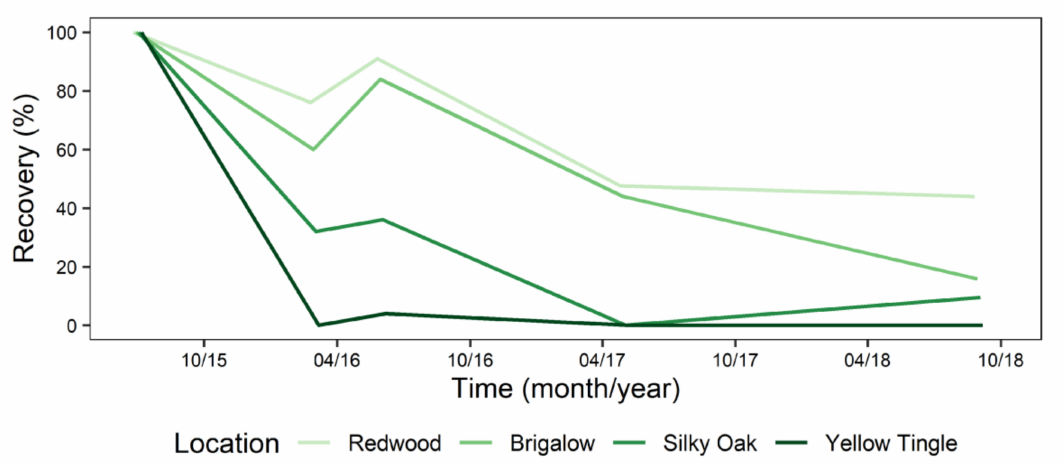
Figure 7. Mean recovery of Phytophthora cinnamomi from four bunds in the McCoy location in Huntly minesite at 30 cm